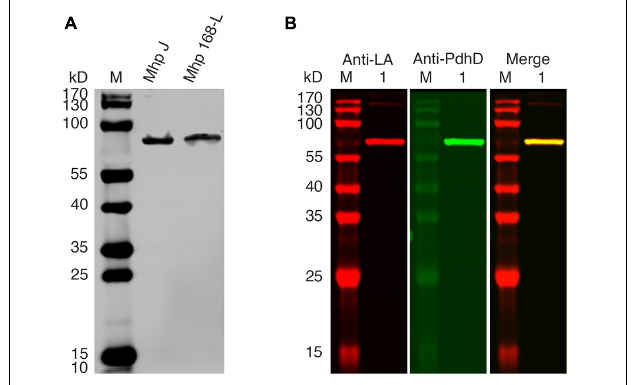
FIGURE 2 | PdhD is the lipoylated subunit in M. hyopneumoniae . (A) M. hyopneumoniae strain J and strain 168-L were analyzed by western blot using Anti-LA. (B) PdhD expressed in the M. hyopneumoniae J strain was probed with Anti-LA and Anti-PdhD. Lane M is the molecular weight ladder. Lane 1 is the cell lysate of the M. hyopneumoniae J